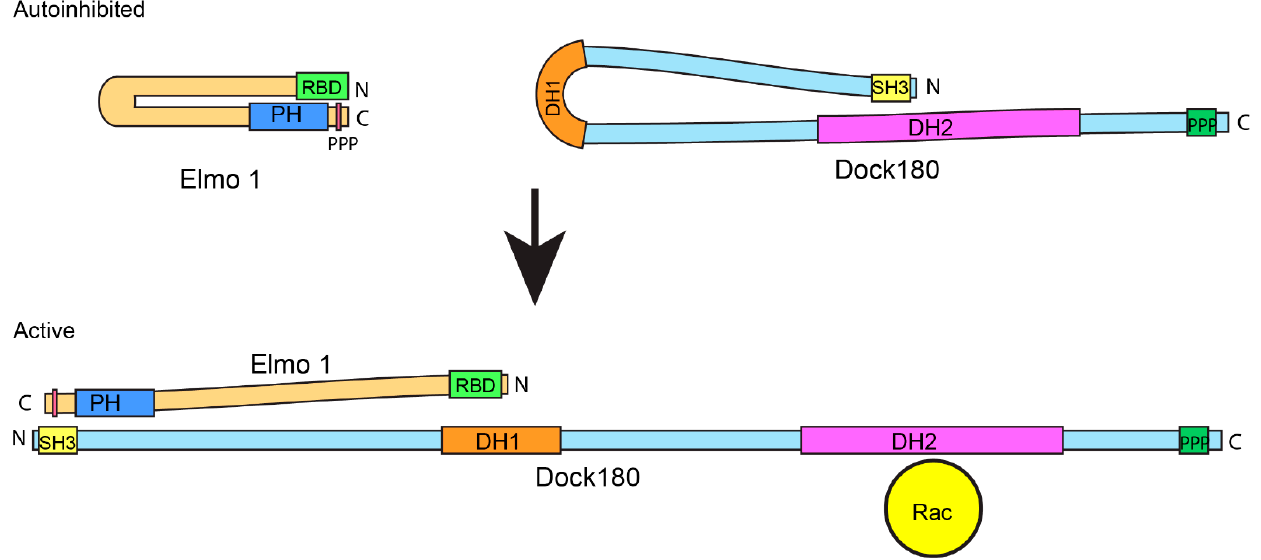
Figure 2. Control of Dock180 dependent Rac activation by autoinhibition. Both Dock180 and Elmo1 have intramolecular autoinhibitory interactions that control their activity. The N-terminal regions of Elmo bind to its C-terminus, while the Dock180 SH3 domain interacts with portions of the DH2 domain. When Elmo’s autoinhibitory interaction is disrupted then the Elmo poly-proline motif can bind to the Dock180 SH3 domain. This releases the DH2 domain which then binds to and activates Rac.